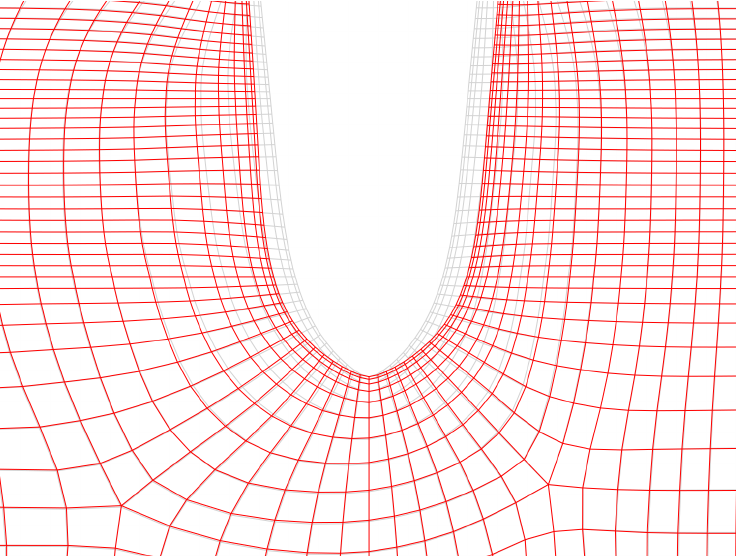
Figure 13. Mesh in the bow region for the baseline (grey) and a modified hull shape